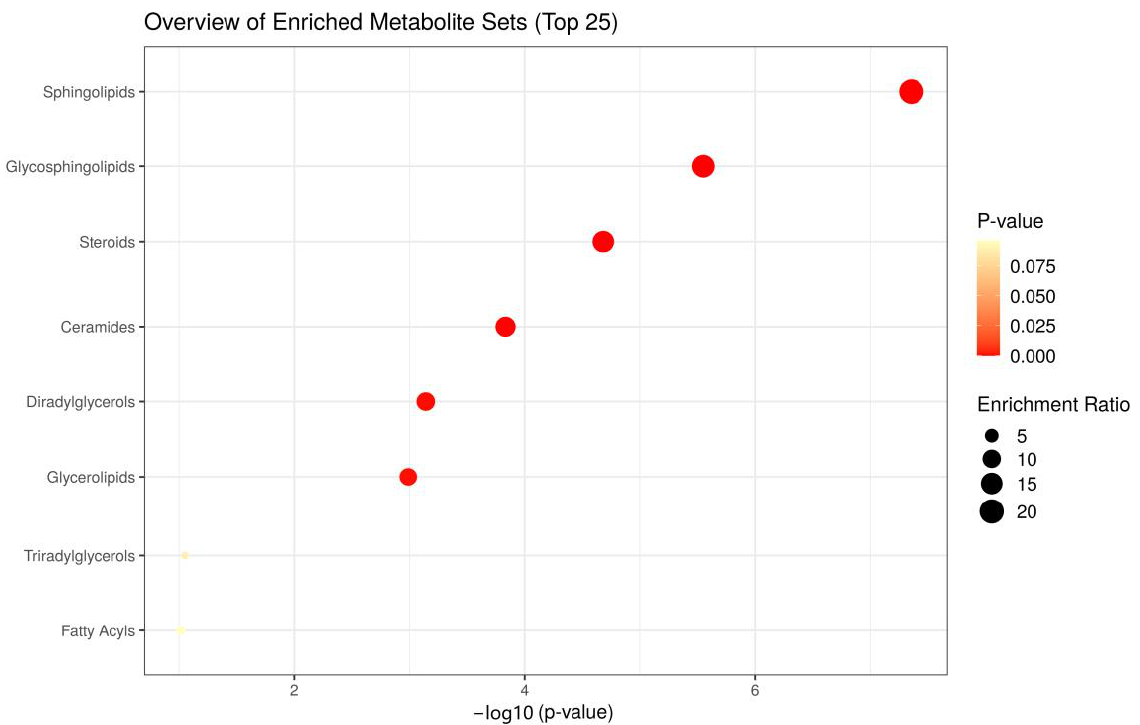
Figure 5. Metabolic pathway maps of important individual lipids responsible for differentiating between the smoking and control